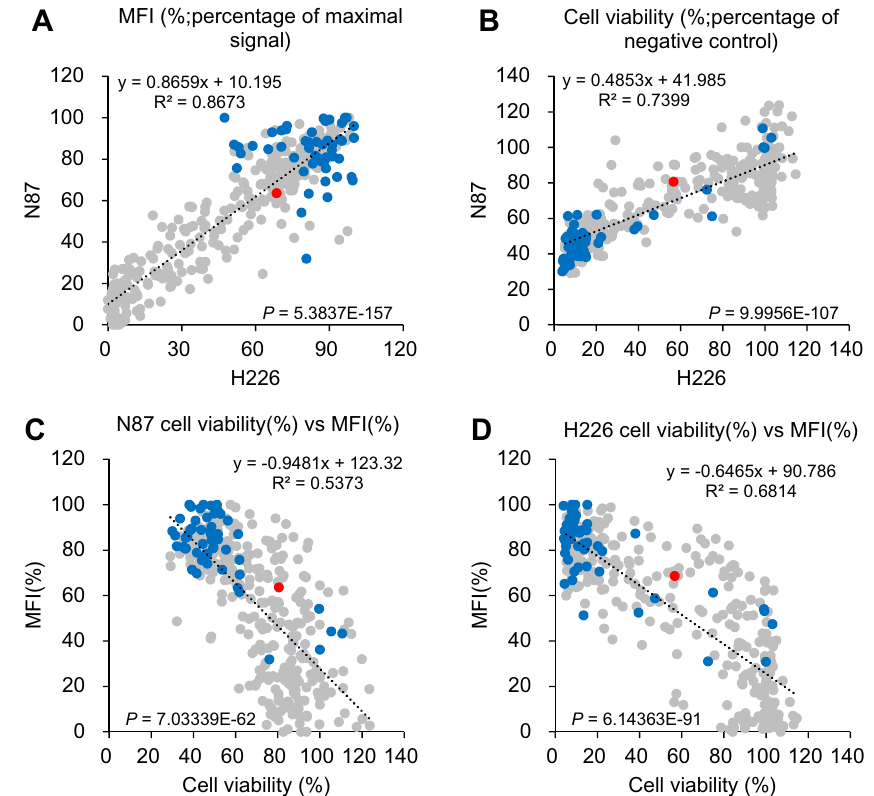
Figure 3. Binding and cytotoxicity characterizations of the scFv CDR-variants of M9 as targeting candidates for anti-MSLN ADCs. ( A ) Mean fluorescence intensities (MFIs) for each of the AL1-RFP-conjugated scFv CDR- variants of M9 binding to N87 and H226 cells are shown in the y-axis and x-axis respectively. The MFIs were normalized to the percentages of the corresponding maximal signal to facilitate the comparison of the binding of the scFvs to N87 and H226 cultured cells. ( B ) Percentages of cell viability of N87 and H226 cell cultures treated with each of the AL1-PE38KDEL-conjugated scFv CDR-variants of M9 are shown in the y-axis and x-axis respectively. The cell viability was normalized to the percentage of the cell viability of the corresponding negative control to facilitate the comparison of the cytotoxicities of the scFv-based immunotoxins to N87 and H226 cultured cells. The panels of ( C ) and ( D ) show the correlation of MFI (y-axis) versus cell viability (x-axis) for N87 and H226 cultured cells respectively. The data points for the M9 scFv are colored in red; the data points in grey and blue are the scFv CDR-variants of M9, for which the sequences are shown in Supplementary Table S1. The blue data points are the scFv candidates selected, in the studies followed, to be reformatted into human IgG1 framework for further characterizations as ADC candidates against MSLN. Numerical data and CDR sequence for each of the data points are shown in Supplementary Table